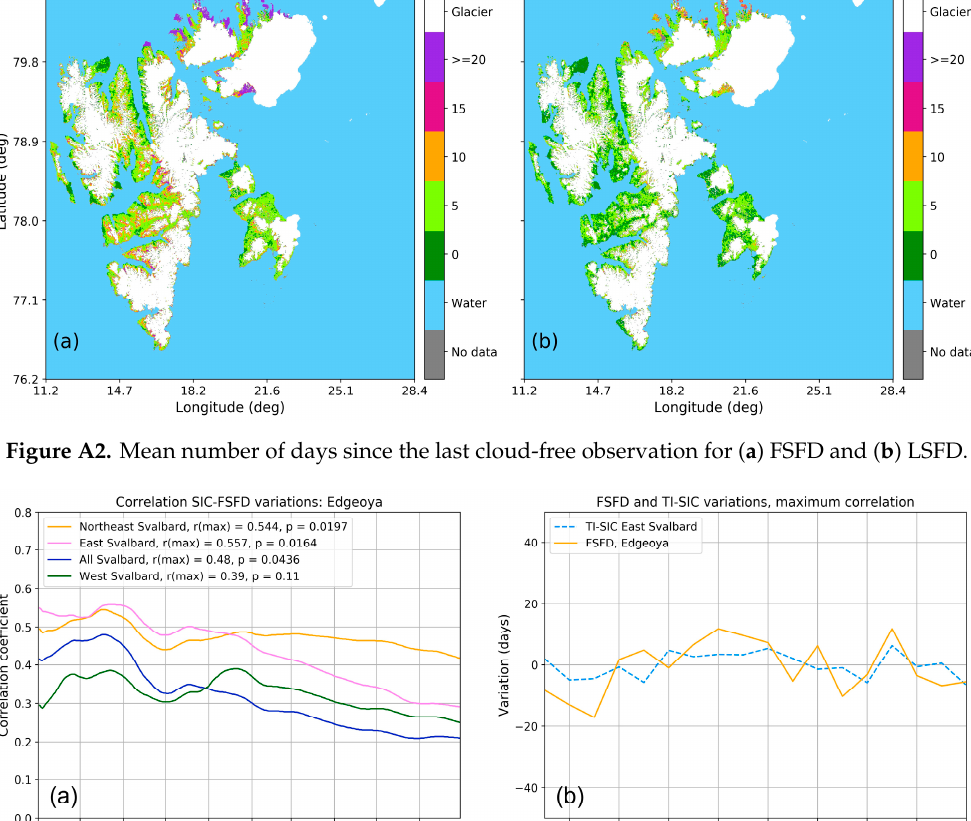
Figure A3. ( a ) Correlation between TI-SIC and FSFD variations averaged over Edgeøya, calculated for SIC integrated from 1 September of the previous year, to each consecutive day of year until 30 June the following year, for the four sea ice regions ( b ). Time series of FSFD variations averaged over Edgeøya together with the time series of TI-SIC variations for the sea region East Svalbard that produced maximum correlation.